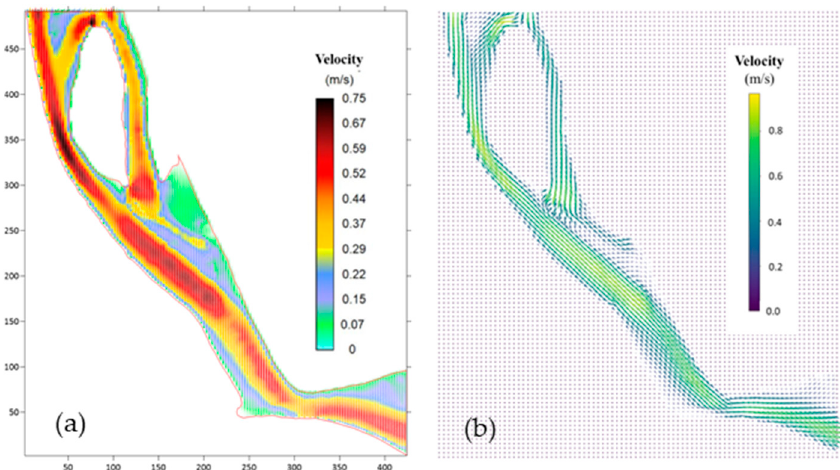
Figure 9. A visual comparison of the vector fields on the CPU (rendered using Surfer) ( a ) and on the graphics processing units (GPU) (rendered using Python) ( b ) after 15 h of simulation using 20 m-grid data.